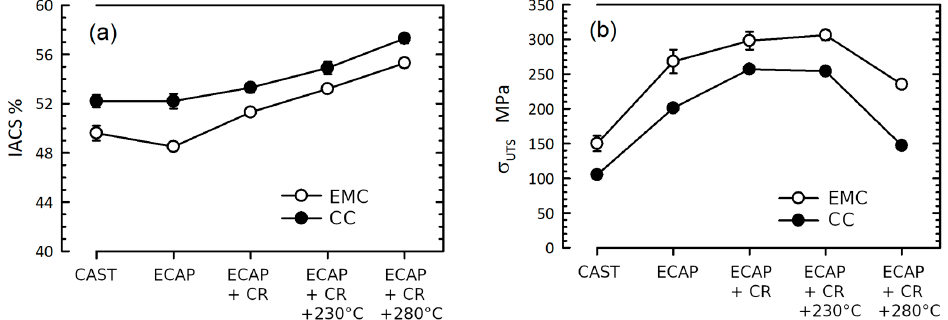
Figure 7. Evolution of the properties of Al–1.7Fe alloys: ( a ) electrical conductivity, ( b ) tensile